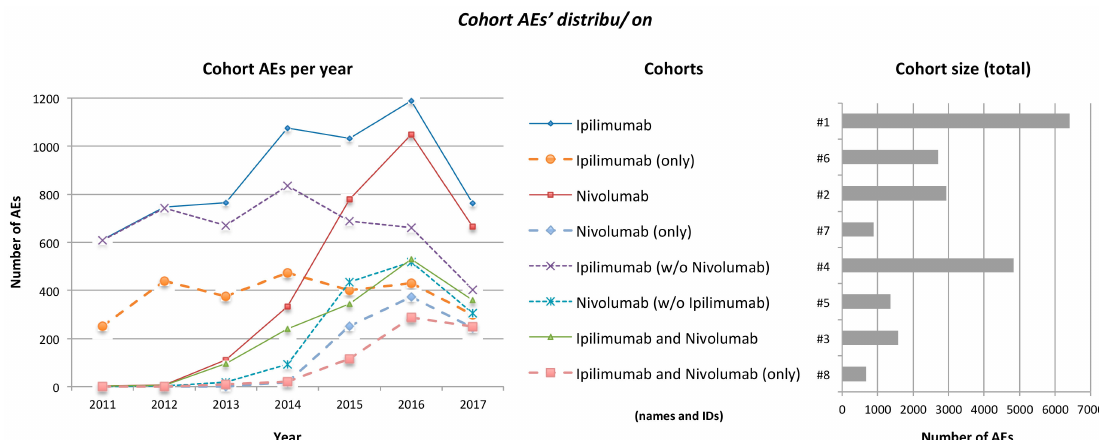
Figure 2. Distribution of cohorts’ AEs over time ( left ) and of cohorts’ total size ( right ). Distribution over time does not include incomplete AEs for which no date was specifically registered or AEs reported prior to 2011; AEs dated prior to a drug’s approval may reflect reports from preapproval studies and clinical trials. The reduction of AE numbers for 2017 is explained by the fact that the full dataset for that year was not yet released by FAERS at the time this analysis took place. FDA approved ipilimumab on 2011 and nivolumab on December